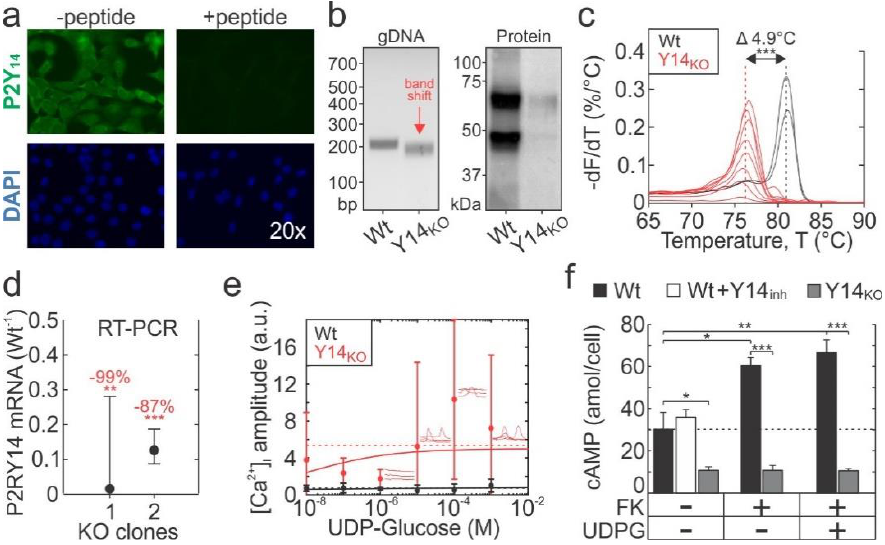
Figure 2. Generation of P2Y 14 knockout C2-Ob cell line with CRISPR-Cas9. ( a ) P2Y 14 immunofluorescence in C2-Ob cells. Fixed cells were incubated with a P2Y 14 antibody (with or without blocking peptide) and then with secondary FITC-conjugated antibody and counter-stained with nuclear DAPI stain. ( b ) P2Y 14 disruption by CRISPR-Cas9 assessed at the level of genomic DNA- (gDNA, by PCR; left panel) and protein (by immunoblotting; right panel). ( c ) Wild-type (Wt) and P2Y 14 knockout (Y14 KO ) amplicon melting analysis performed by RT-PCR. ( d ) P2Y 14 gene expression in two independently isolated Y14 KO clones, relative to Wt cells. Data are means ± 95% CI, n = 2 independent experiments, 2 – 4 technical replicates per experiment. ( e ) Fura2-loaded Wt and Y14 KO cells were stimulated with UDPG and [Ca 2+ ] i elevation amplitudes were estimated from live-cell recordings. Solid curves indicate the Hill function; dashed lines show the global means. Data are means ± sem, n = 3 independent cultures, 8 – 19 cells recorded per culture. ( f ) Intracellular cAMP concentrations in Wt and Y14 KO cells stimulated with 10 µM forskolin (FK) and/or 10 µM UDPG for 30 min before collecting samples for measurement. Data are means ± sem, n = 3 independent cultures. Significance assessed by t-test with Bonferroni correction; p < 0.05 *, p < 0.01 ** and p < 0.001 ***.